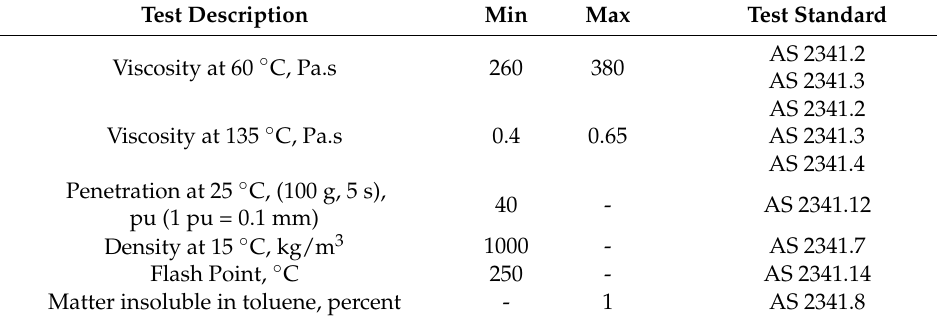
Table 2. Bitumen C320 properties (AS